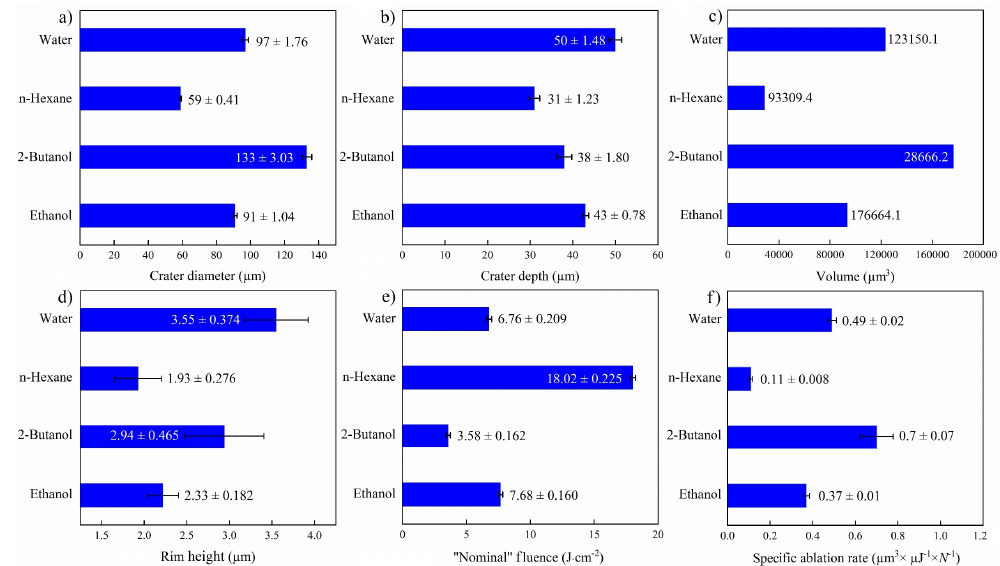
Figure 7. Summary of femtosecond laser ablation properties of Au/Ni in various fluids ( N = 1000, 1 kHz, E = 250 μ J). ( a ): Crater diameter; ( b ): crater depth; ( c ): crater volume; ( d ): rim height, ( e ): “nominal” laser fluence; and ( f ): specific ablation rate.